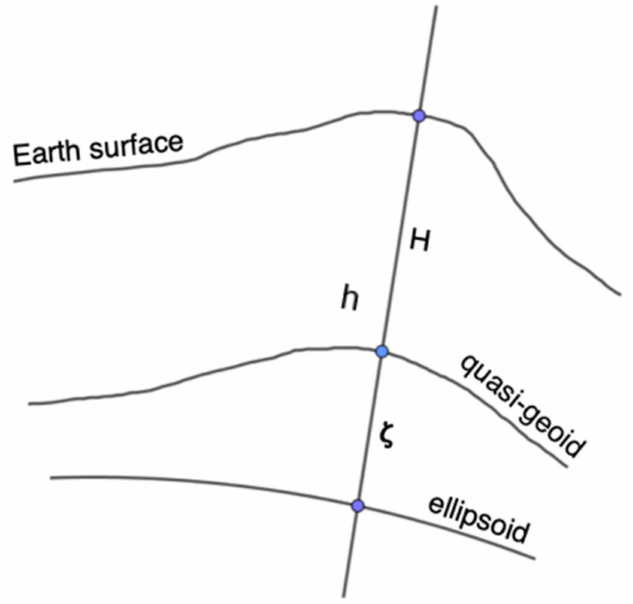
Figure 6. Height H above sea level (quasi-geoid) and height anomaly ζ obtained from the quasi- geoid model. GNSS measurements provided the ellipsoidal height—the sum of H and ζ . Source: own